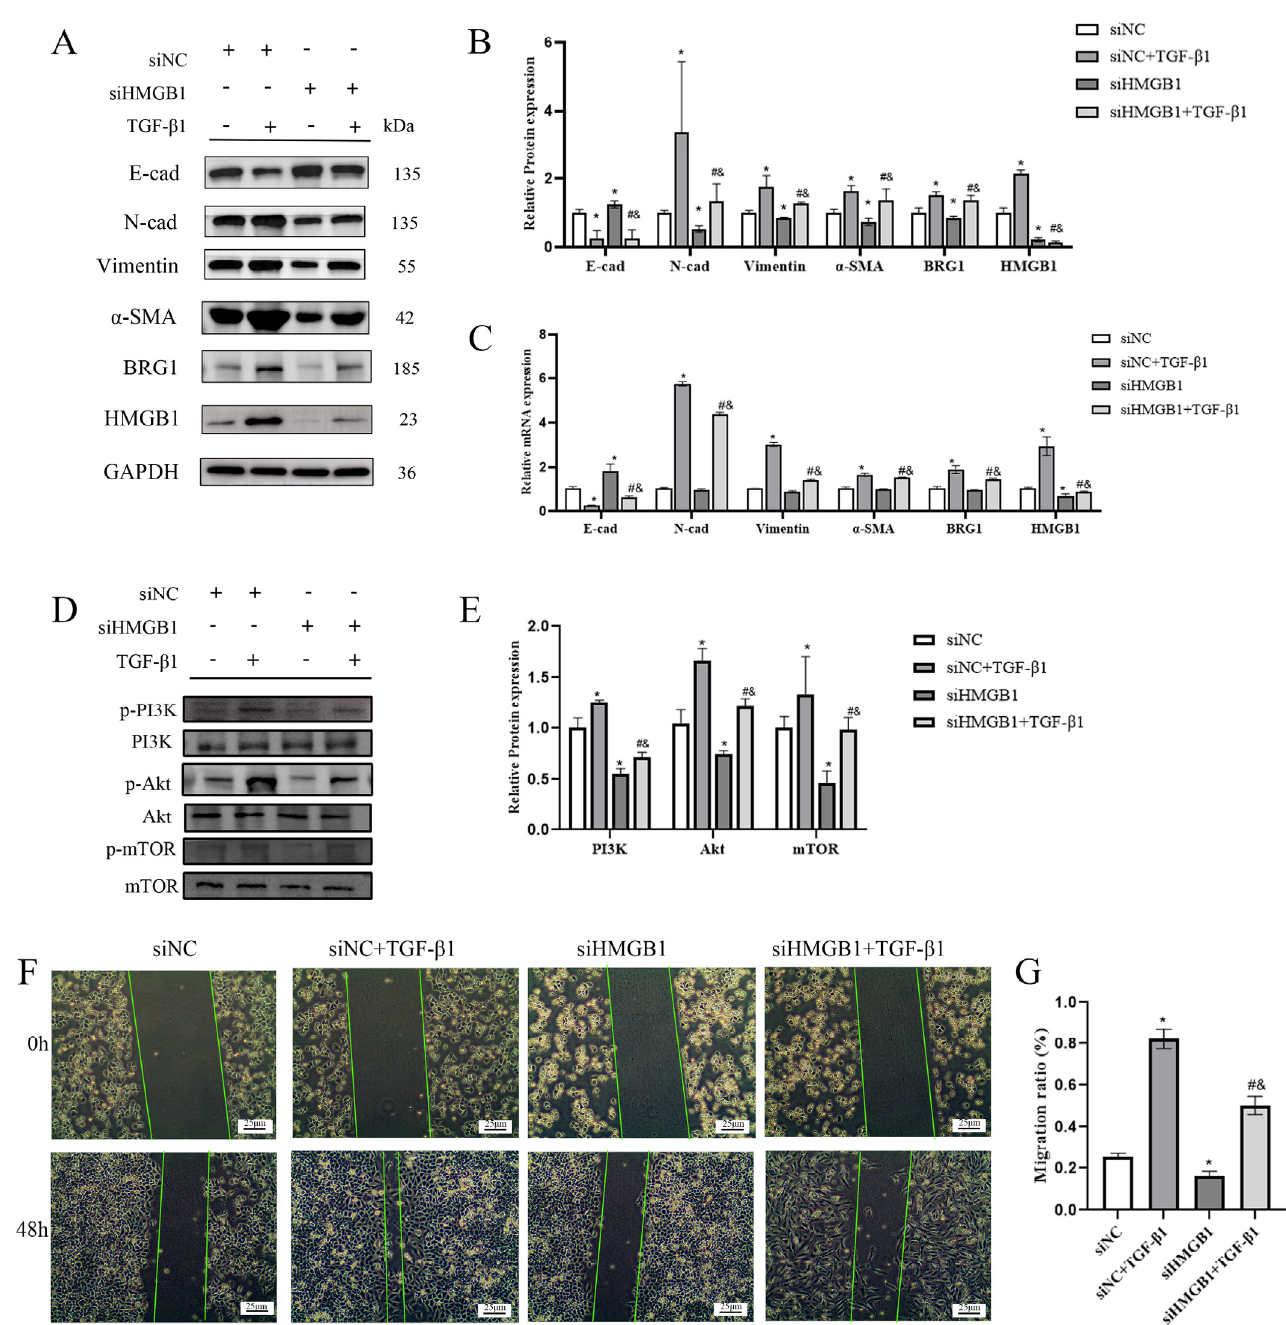
Figure 2. Knocking down HMGB1 can slow down the EMT process through the PI3K/Akt/mTOR pathway. ( A , C ) After silencing HMGB1, cultured in normal medium or medium containing 5 ng/mL TGF- β 1 for 48 h. The expression of E-cad, N-cad, Vimentin, α -SMA, HMGB1, BRG1, and GAPDH were detected by Western blotting and RT-qPCR. ( B ) Quantification. ( D ) After silencing HMGB1, the expression of PI3K, p-PI3K, Akt, p-Akt, mTOR, and p-mTOR were detected by Western blotting. ( E ) quantification. ( F ) A scratch test was carried out after knocking down HMGB1. ( G ) Quantification. GAPDH was used as an internal control *: p < 0.05 compared with the control group. #: p < 0.05, compared with the siHMGB1 group; &: p < 0.05, compared with the siHMGB1 + TGF- β 1 group.